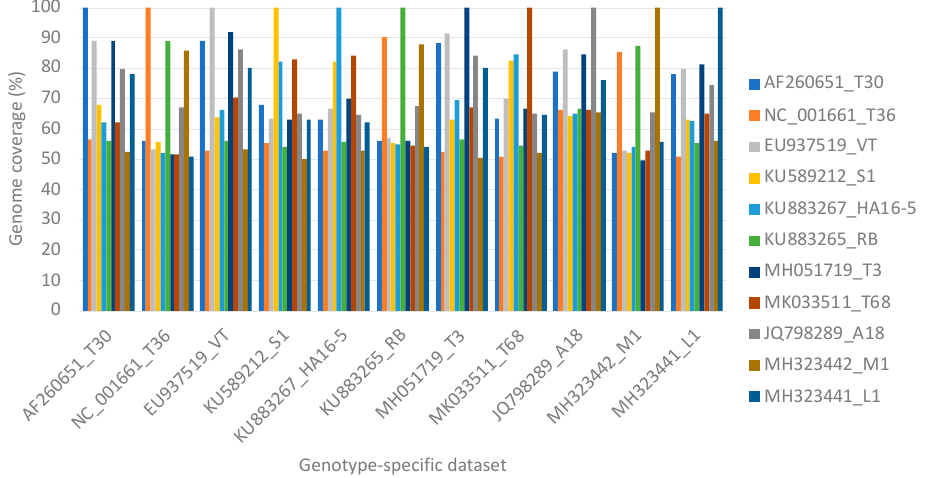
Figure 4. A clustered column chart displaying the genome coverage per representative genotype after read mapping one million read pairs of genotype-specific data on each of the genotype sequences individually.